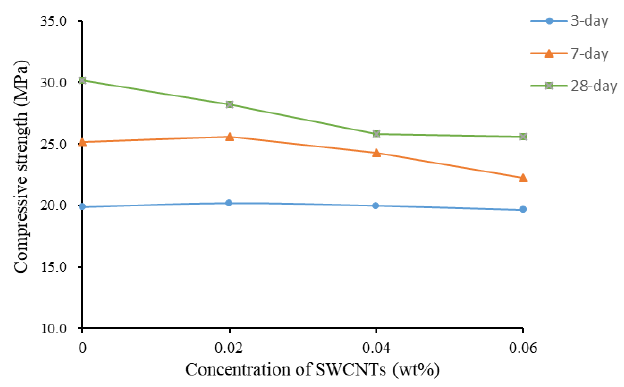
Figure 4. Compressive strength as a function of concentration of SWCNTs (No TX10).